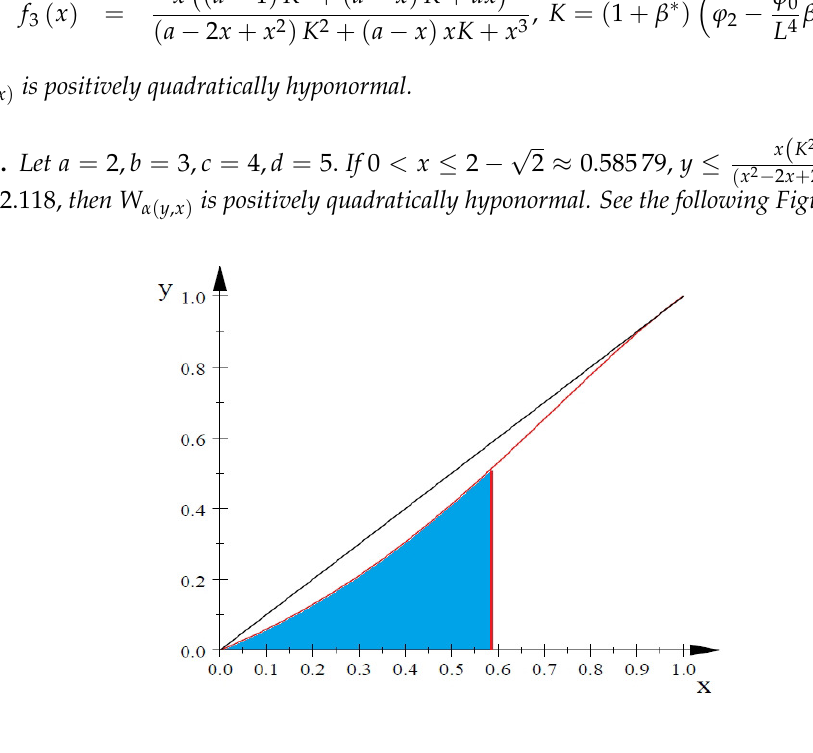
Figure 1. A subset of the region of positive quadratic hyponormality of W α ( y , x ) in Example